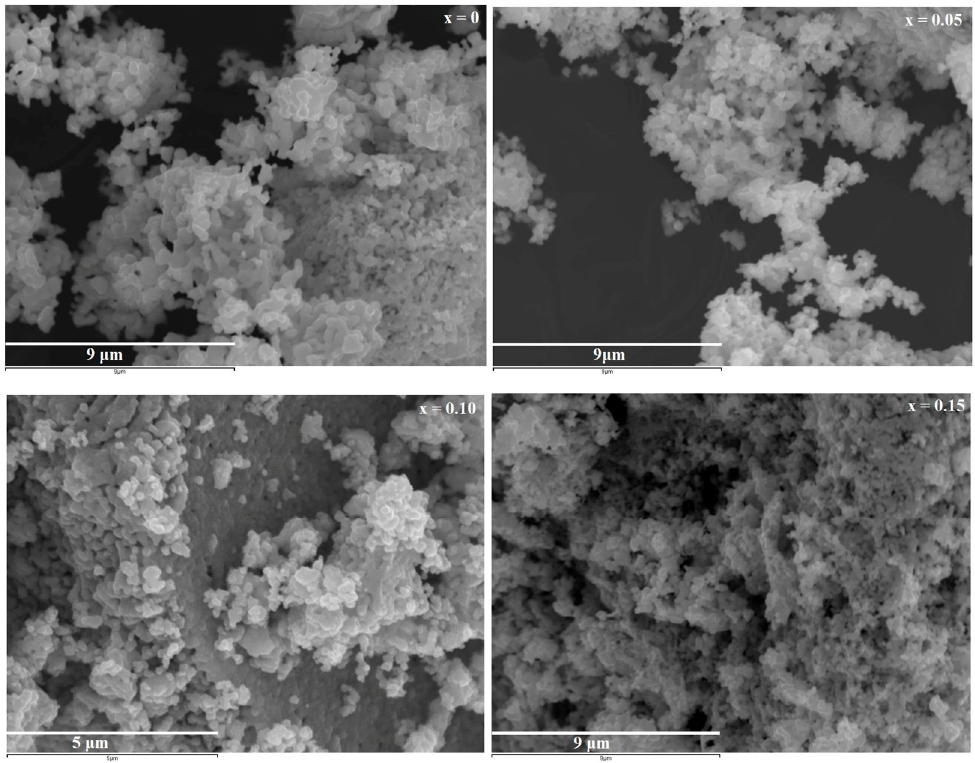
≤ x ≤ 0.15) samples. 0.7 Sr 0.3 Mn ( 1 − x ) Co x O 3 (0